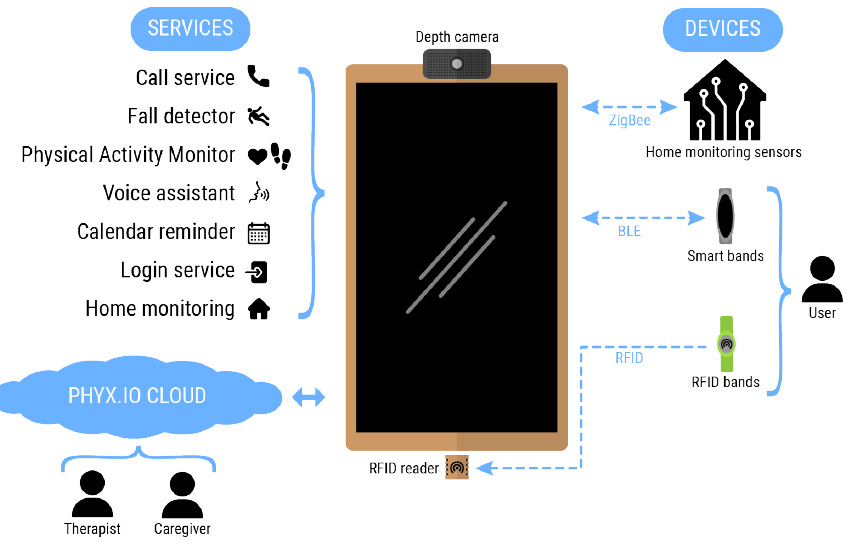
Figure 1. The SHAPES smart mirror ecosystem. Table 3. Summary of services supported by the smart mirror (inputs, outputs and key